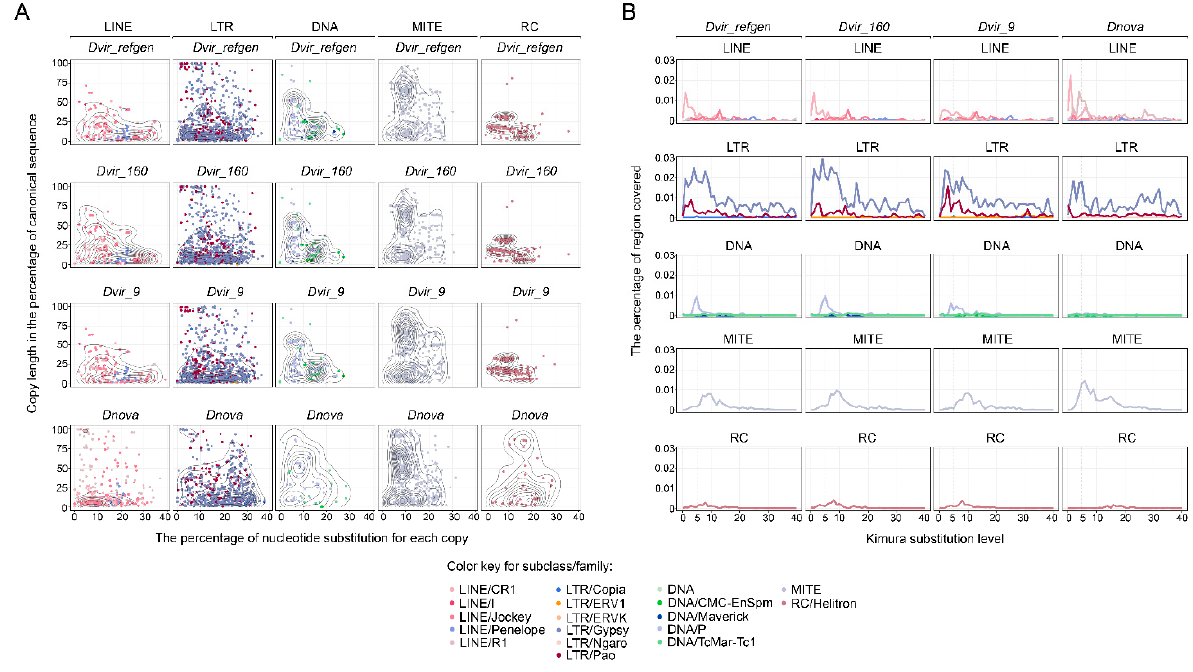
Figure 5. Divergence of transposable elements and the estimated age of X-heterochromatic region in different D. virilis strains and closely-related species D. novamexicana . ( A ) The relationship of nucleotide substitutions in transposable element copies (the x-axis) to the length of copies (the y-axis). The length of copies is calculated as the percentage from a canonical copy of a transposable element. Each dot represents a single copy of an element. ( B ) Comparison of genetic distances (Kimura 2-distance) of transposable element families in heterochromatic regions.